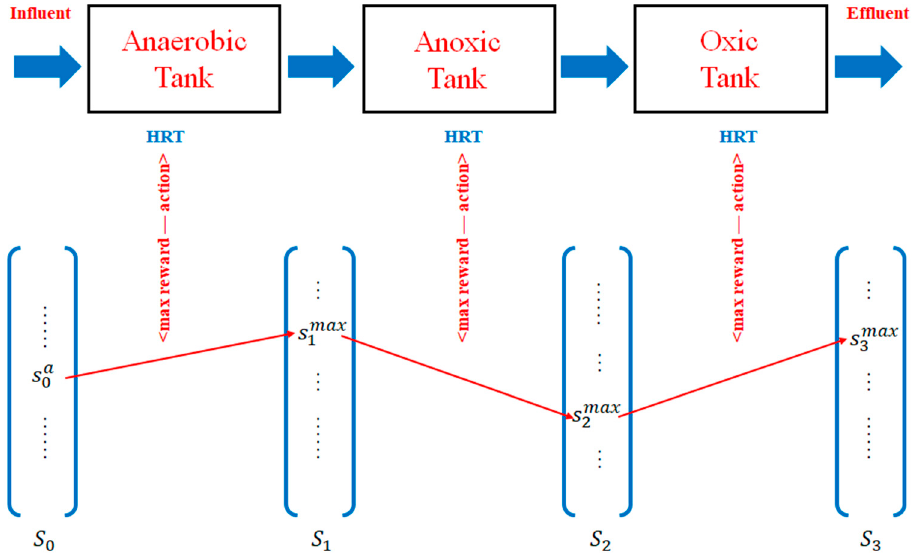
Figure 4. Simplified mapping functions for HRTs optimization in AAO system by an integrated ASM-QL algorithm.